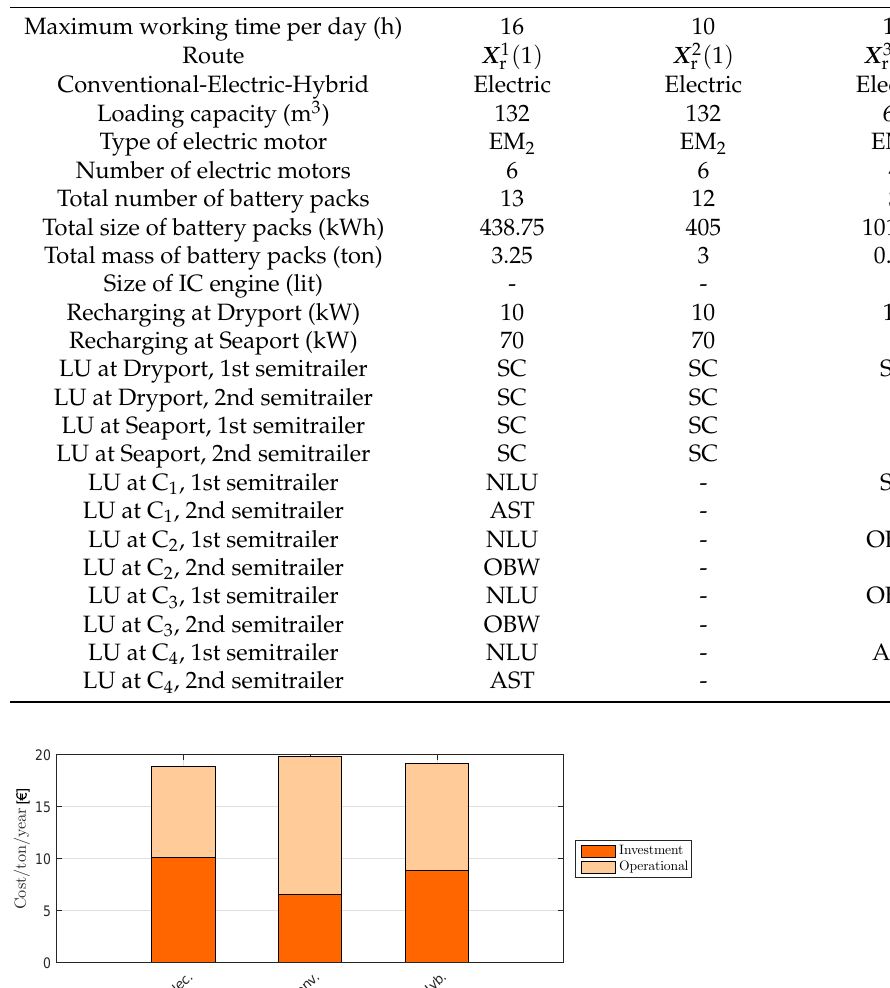
Figure 13. Annual cost per unit freight incurred when using optimum conventional, fully electric, and hybrid vehicles during first mission. Vehicles and corresponding missions, in which they are utilized, are marked with the same color.